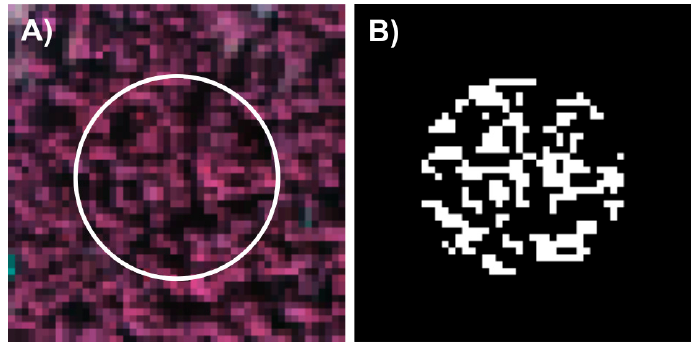
Figure 2. Definition of the Norway spruce sampling stands in the original APEX data ( A ) and binary mask of the sunlit tree crowns ( B ).